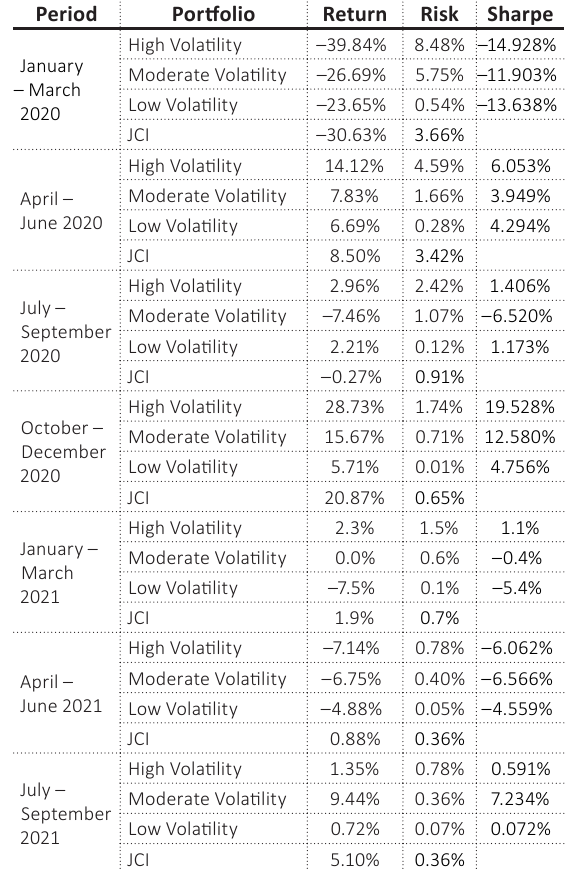
Source: Processed